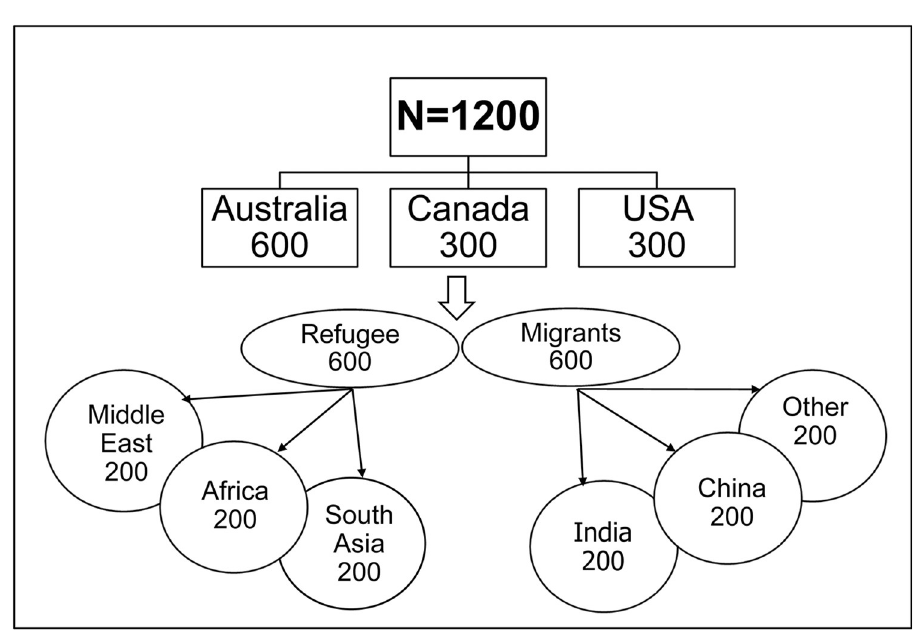
Fig 1. Design of the survey